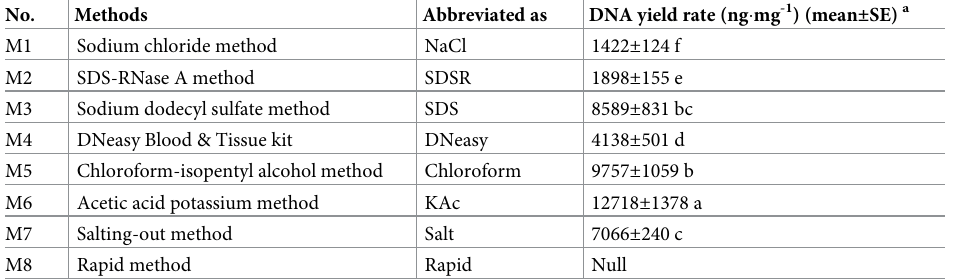
Means followed by different lowercase letters are significantly different at P < 0.05 (one-way ANOVA, Tukey’s